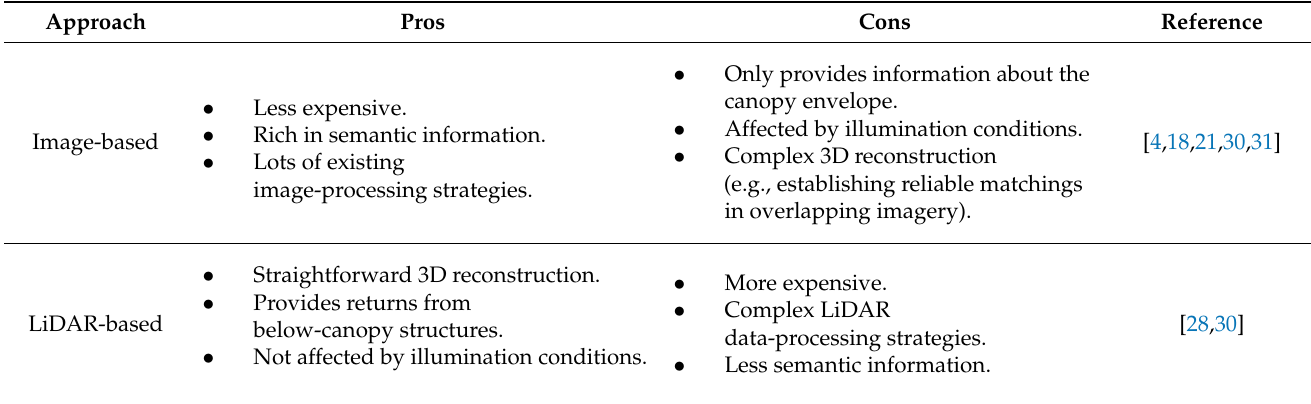
Table 1. Synergistic characteristics of imaging and LiDAR technologies for mapping/documentation of archaeological